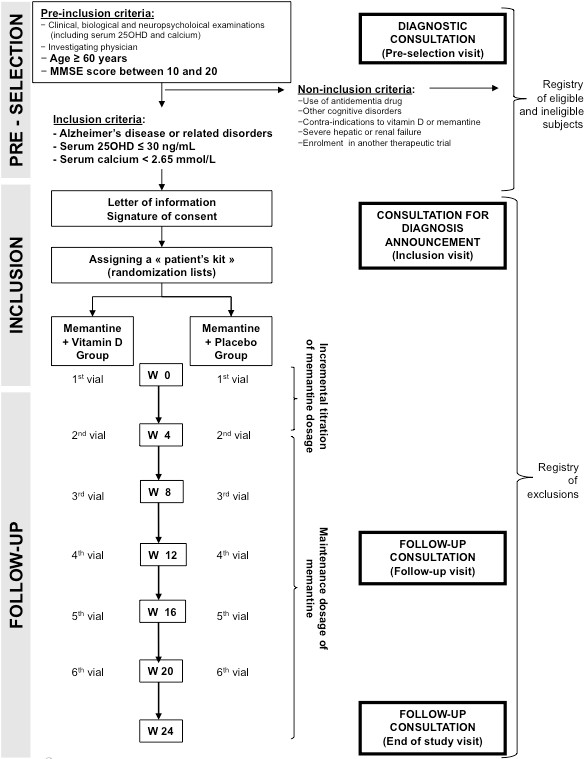
Trial flow chart. Flow chart of the Trial Study.